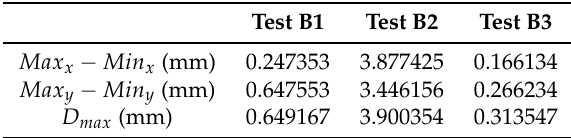
Table 2. The horizontal and vertical spans of measured target positions and maximum distances from their respective average centers for the three manual registration tests